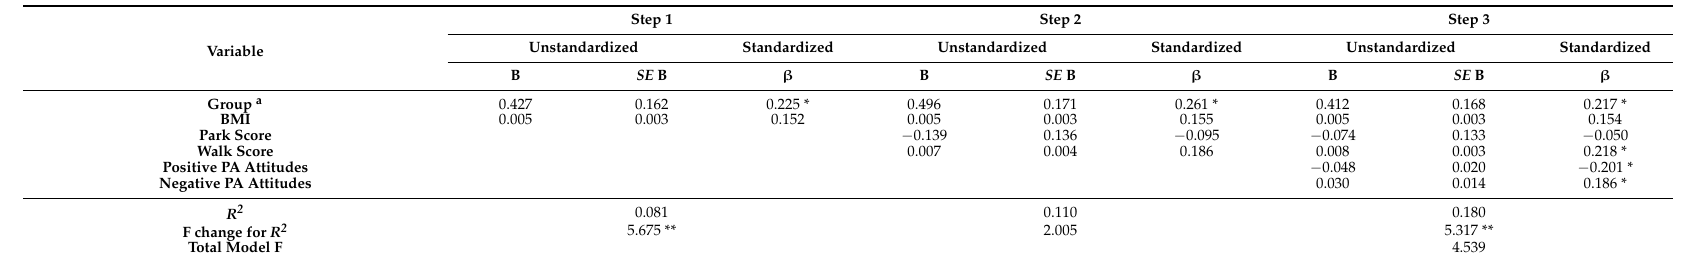
Table 6. Multiple regression of 10-meter walk